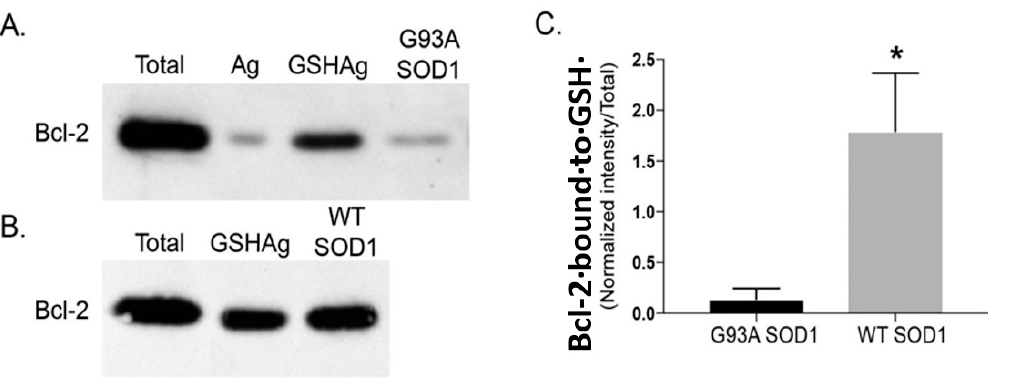
Figure 1. G93A mutant SOD1 decreases Bcl ‐ 2 binding to GSH. ( A ) Recombinant Bcl ‐ 2 (50 ng) was incubated with agarose beads (Ag), GSH agarose beads (GSHAg), or GSHAg in the presence of 25 ng G93A SOD1, and proteins were resolved by SDS ‐ PAGE and immunoblotted for Bcl ‐ 2. ( B ) Re ‐ combinant Bcl ‐ 2 was incubated with GSH agarose beads (GSHAg) alone or in the presence of 25 ng WT SOD1, and proteins were resolved by SDS ‐ PAGE and immunoblotted for Bcl ‐ 2. ( C ) Quantifica ‐ tion of Bcl ‐ 2 bound to GSH showing a reduced binding in the presence of mutant G93A SOD1 re ‐ combinant protein. Mean ± SEM; * p < 0.05, unpaired Student’s t ‐ test ( n = 3 independent experi ‐